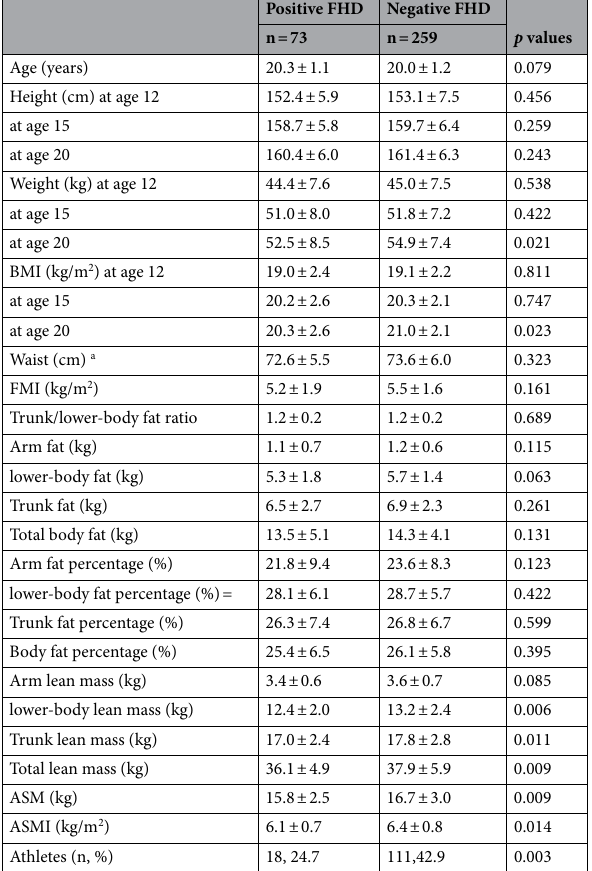
Table 3. Anthropometric characteristics of young Japanese female athletes and non-athletes in the presence and absence of family history of type 2 diabetes (FHD). Mean ± SD or n, %. a n = 57 and 96 of positive and negative family history, respectively. Abbreviations are the same as in Table 1.